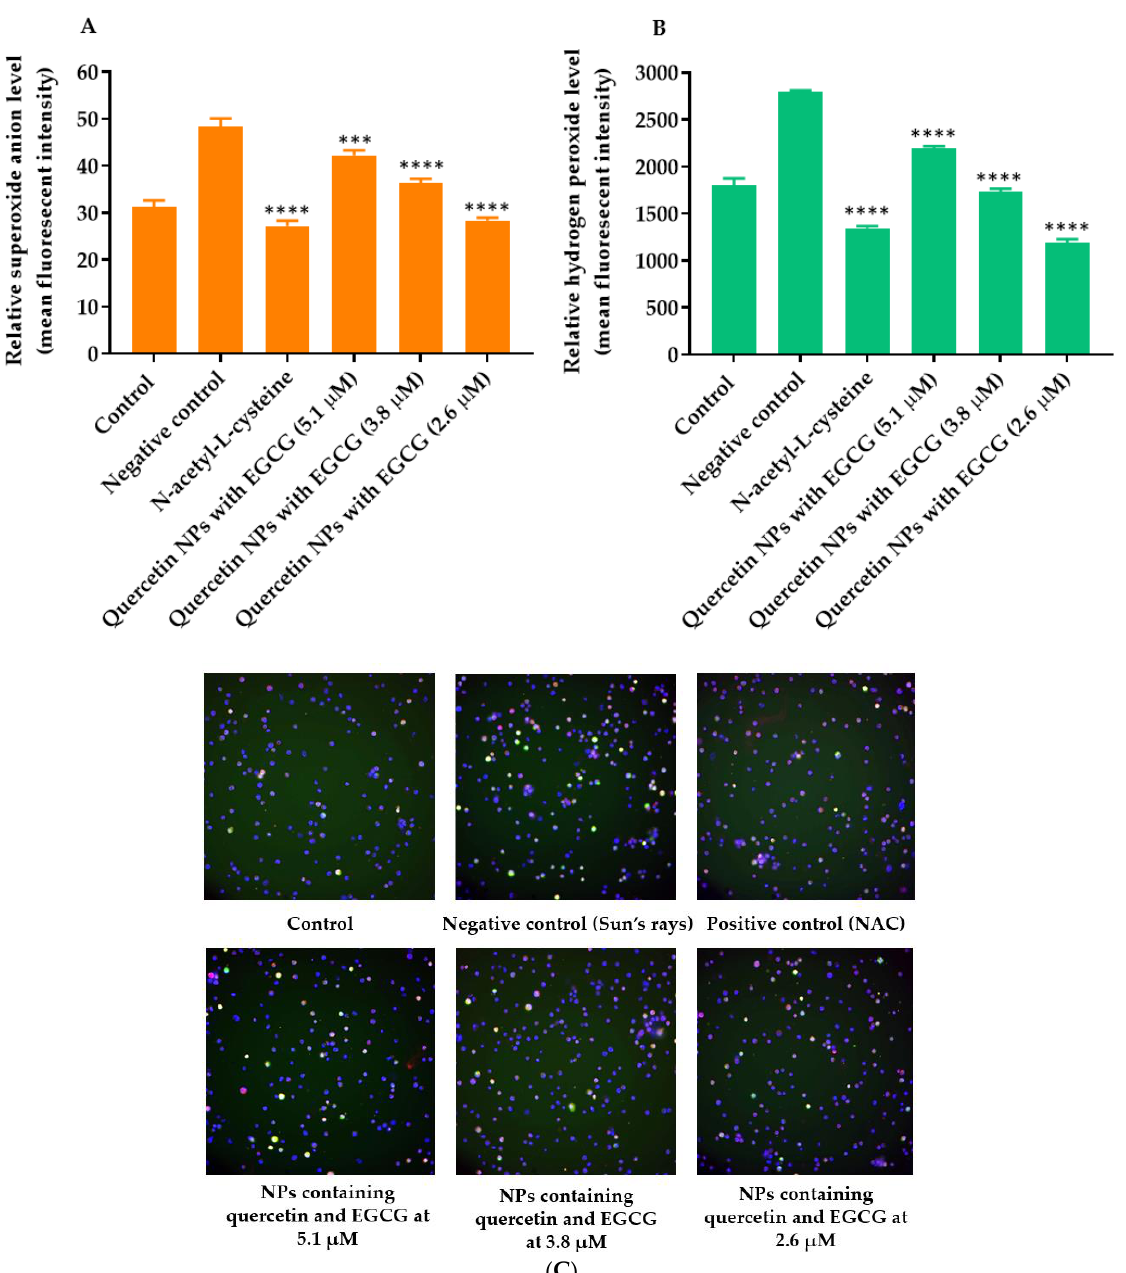
Figure 9. Effect of quercetin loaded PLGA NPs combined with EGCG on intracellular ROS generation. ( A ) Quantification of the hydrogen peroxide levels within the indicated groups. ( B ) Quantification of the superoxide anion levels within the indicated groups. ( C ) Fluorescence microscopy of the HCE cells treated with fluorescent probes after cultivation in the presence and absence of simulated-Sun-ray oxidative stress and the treatment with quercetin loaded PLGA NPs and EGCG. *** and **** indicate p < 0.001 and 0.0001 compared with control, respectively.